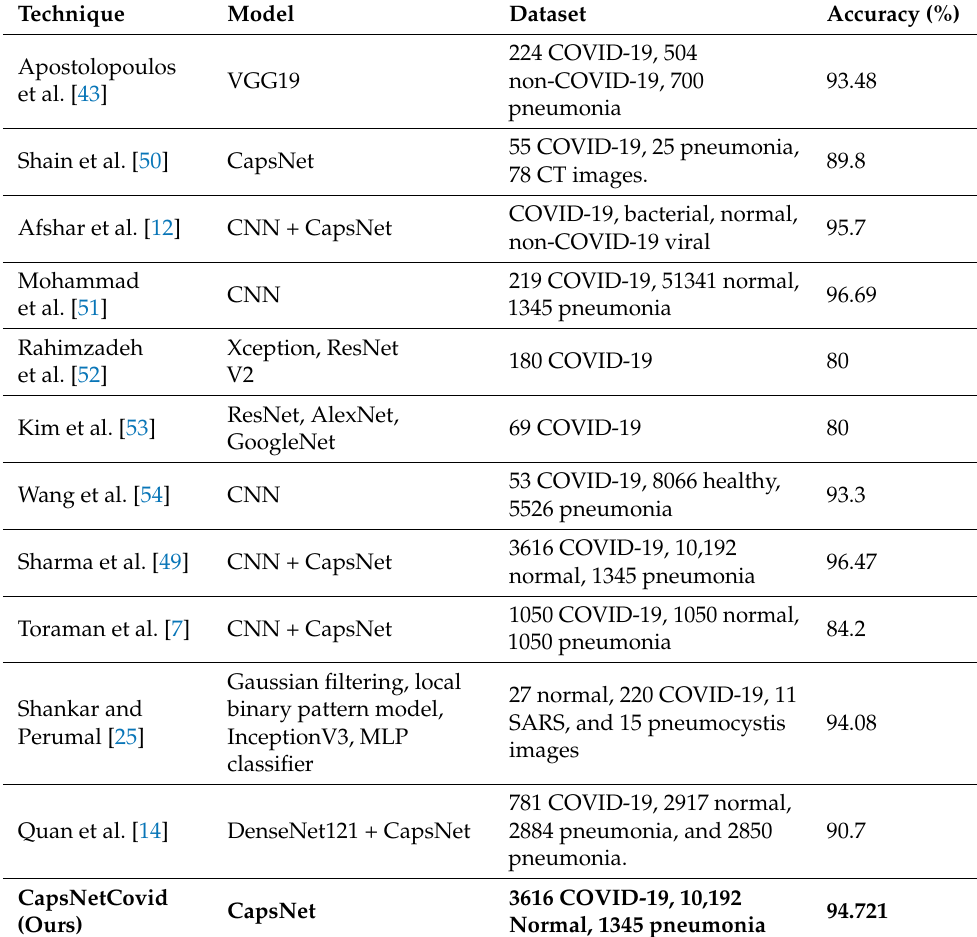
Table 17. CapsNetCovid versus existing COVID-19 diagnosis technique for multi-class